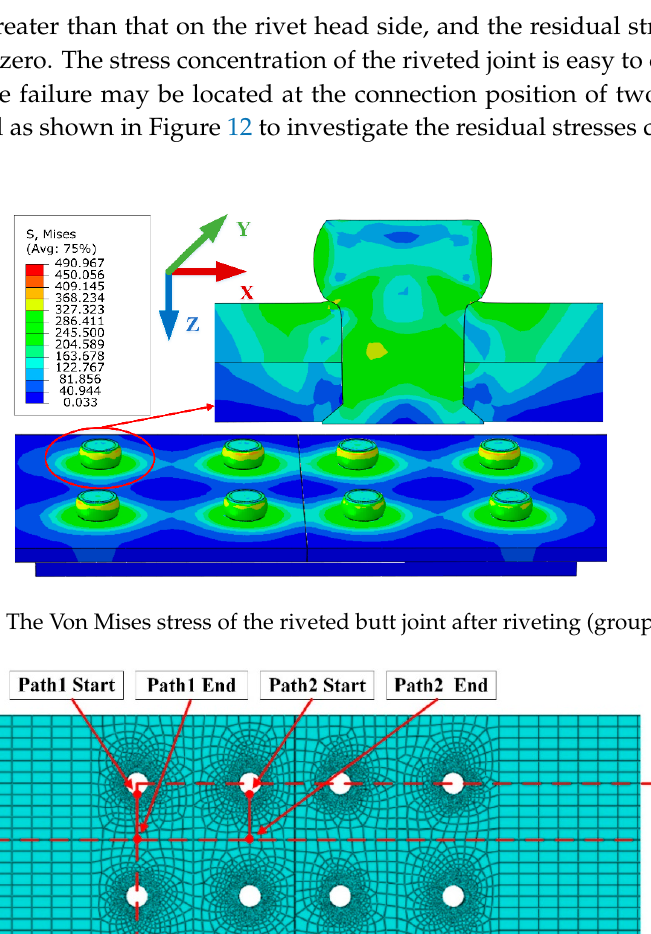
Figure 12. Two paths between adjacent rivets for residual stress distribution investigation.